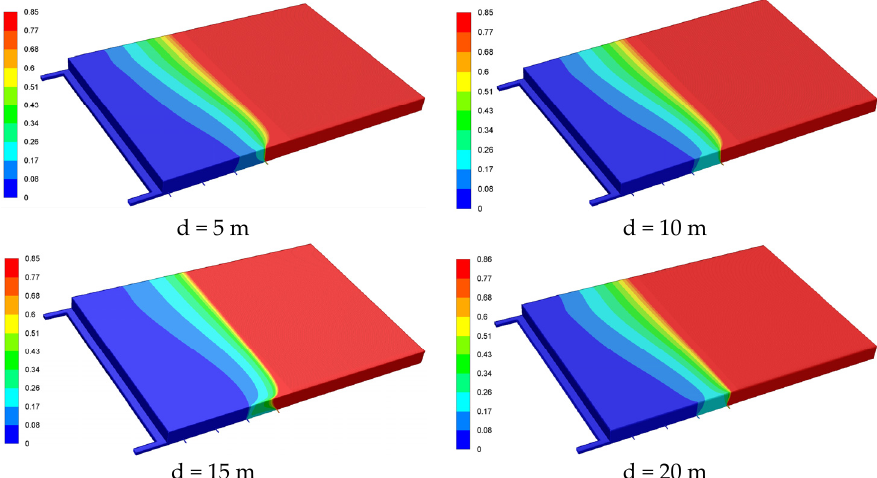
Figure 6. Distribution of methane concentration under different distance between the first borehole and the upper corner.